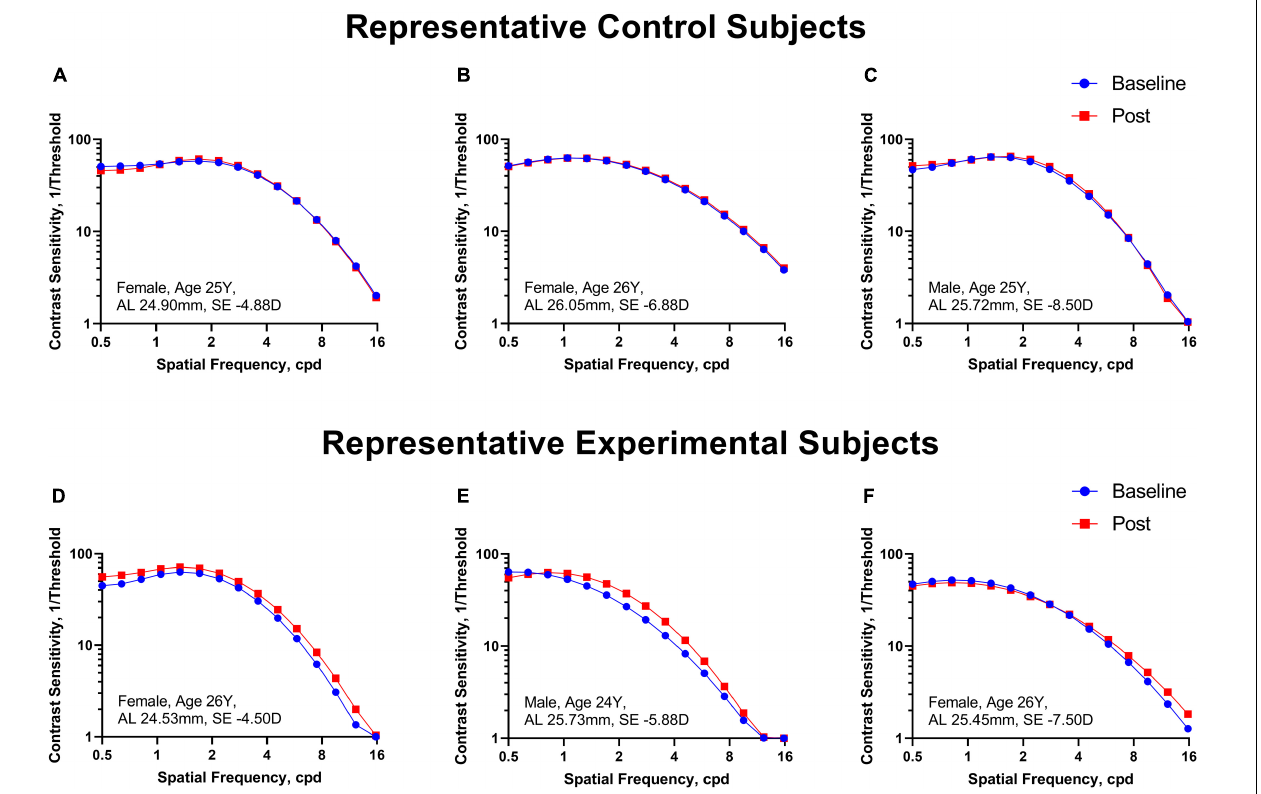
FIGURE 2 | The CSF curves in six representative cases from the control and experimental groups. (A–C) Control group. (D–F) Experimental group. Cpd, cycle per